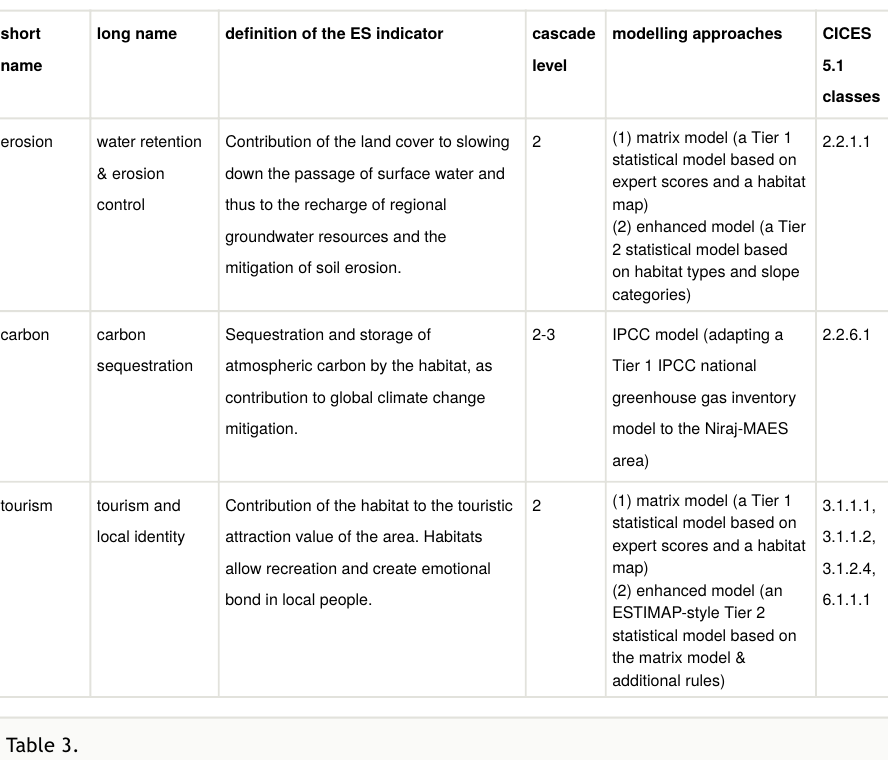
Two sets of criteria for identifying indicators for the ES assessments. Phase I: criteria for selecting the 'topics' for which we need indicators; Phase II: criteria for selecting speci fi c indicators (=data and methods) for each topic. CSL means credibility, salience and legitimacy; see Cash et al.